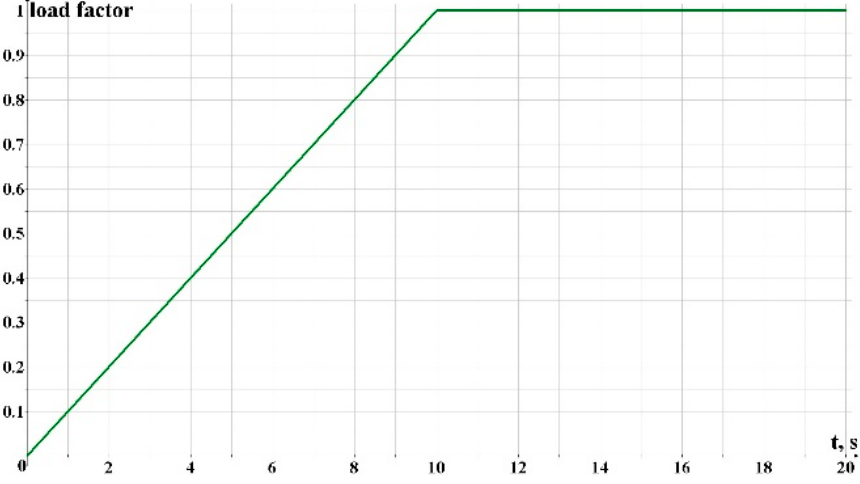
Figure 7. The graph of the application of an external load on the structure.